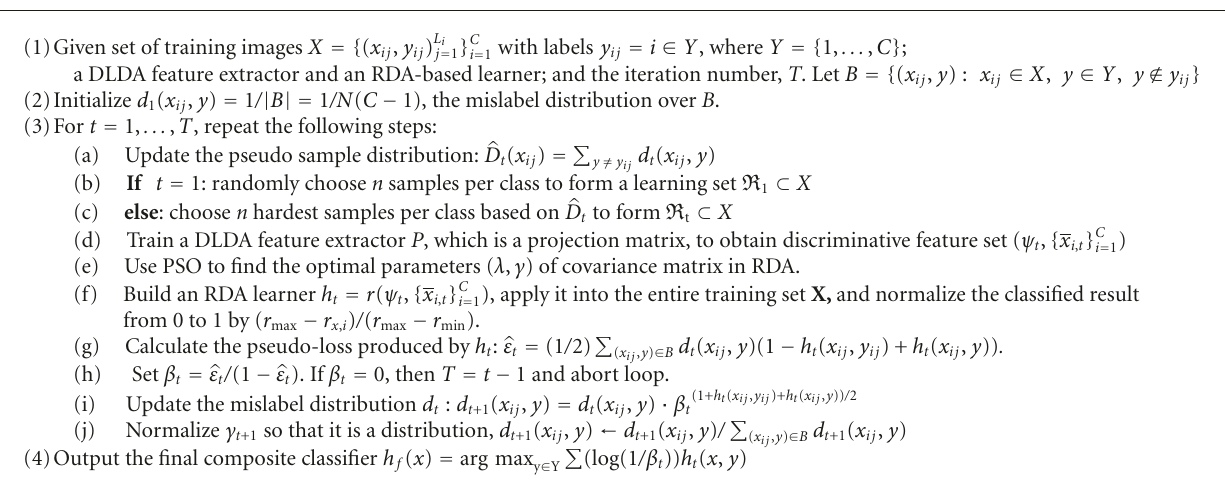
Algorithm 1: RDA-based boosting algorithm.